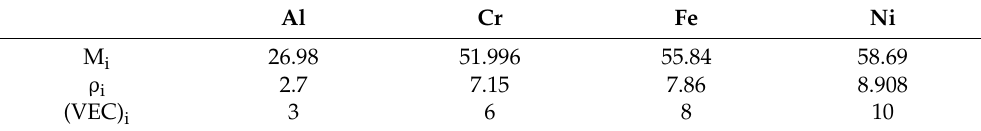
Table 1. Physiochemical properties for the used elements (from the periodic table